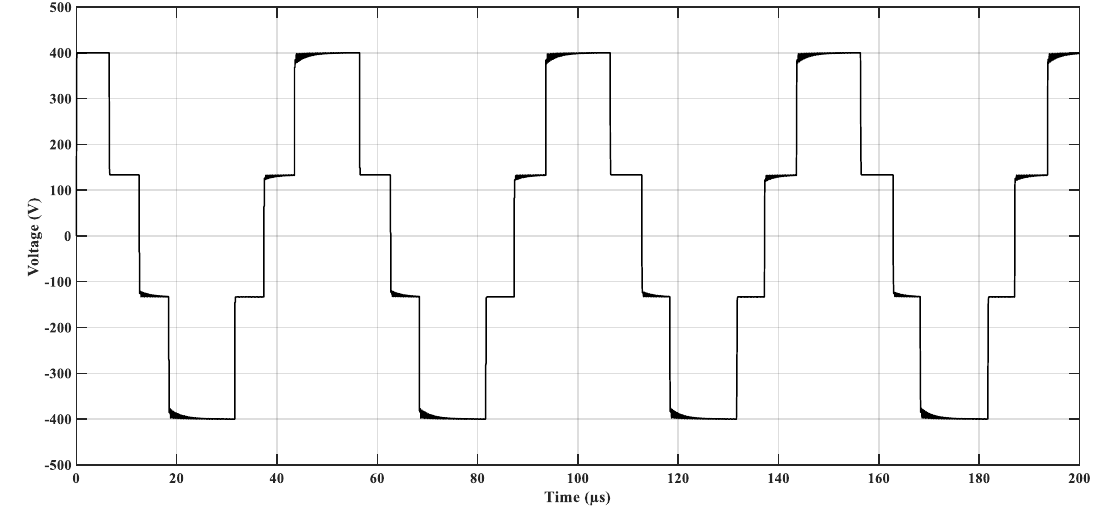
Figure 6. Common-mode voltage without the ACMVC.